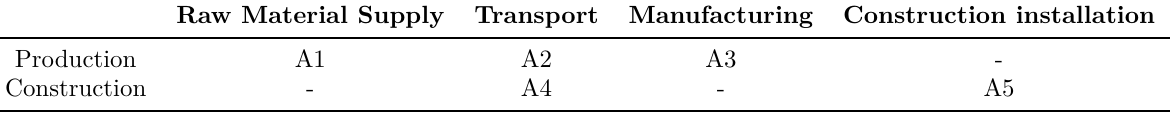
Table 2. LC stages A Modules/Production & Construction Stages.